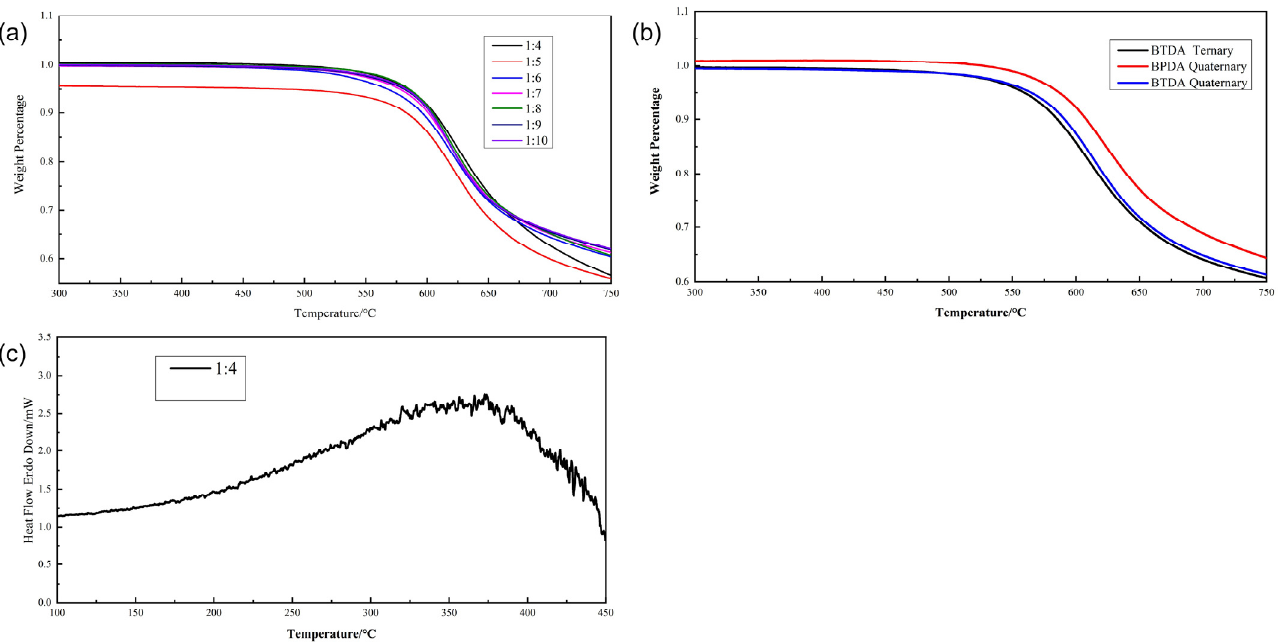
Figure 8. Thermal performance diagram of films in group TFOP and group TFOB. ( a ) TGA curves of films in group TFOP ( b ) TGA curves of films in group TFOB ( c ) DSC curve of films in PI film when TFMB:ODA = 1:6.